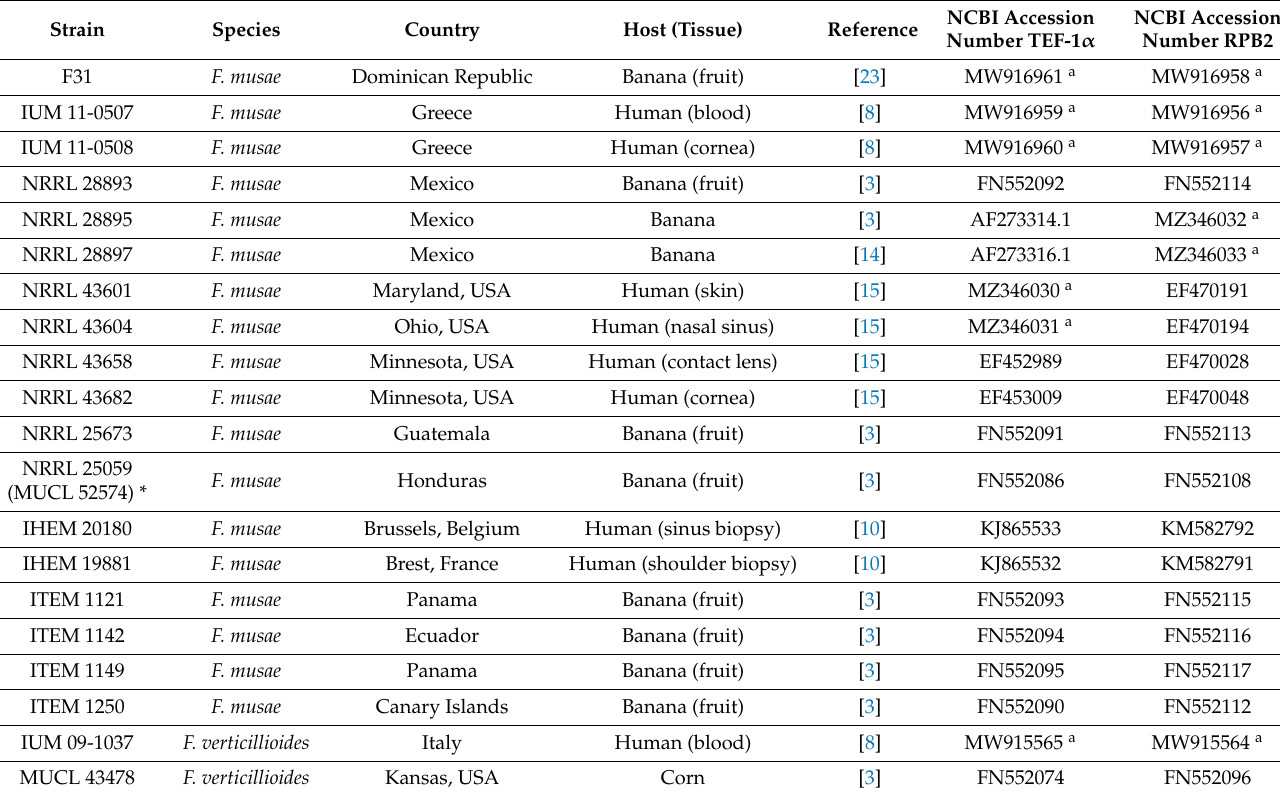
Table 1. Collection of strains of F. musae and F. verticillioides used in this work. The name of each strain, its species, country of origin, host species and tissue type, [references] and GenBank accession numbers for TEF-1 α and RPB2 are reported.